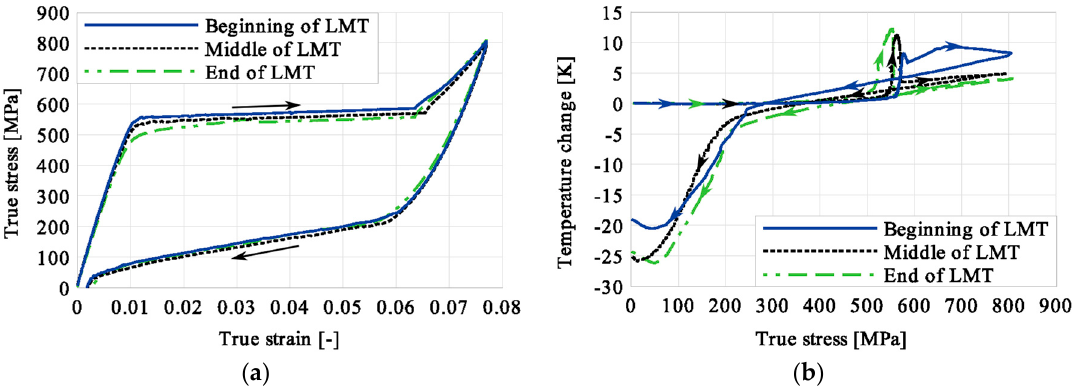
Figure 17. Comparison of experimental data obtained for TiNi SMA tension with 3-min loading interruption induced at the beginning (Program 1), middle (Program 2) and end (Program 3) of LMT: ( a ) stress vs. strain; ( b ) temperature change vs. stress.